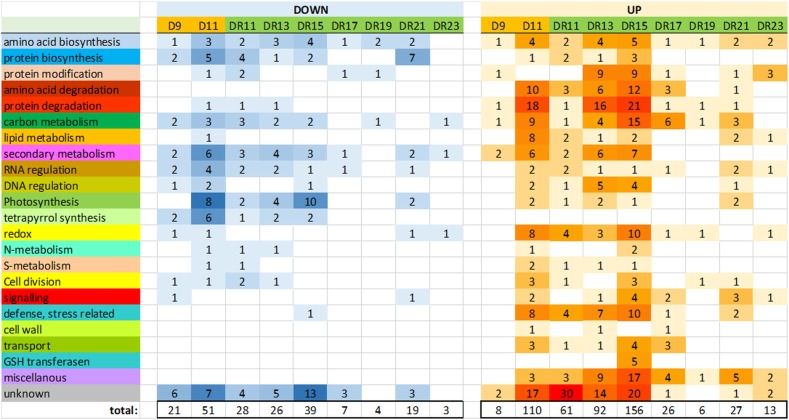
Overview of the number of proteins of major functional (MapMan) categories, which were significantly (p < 0.05) reduced (down) or increased (up) compared to controls.